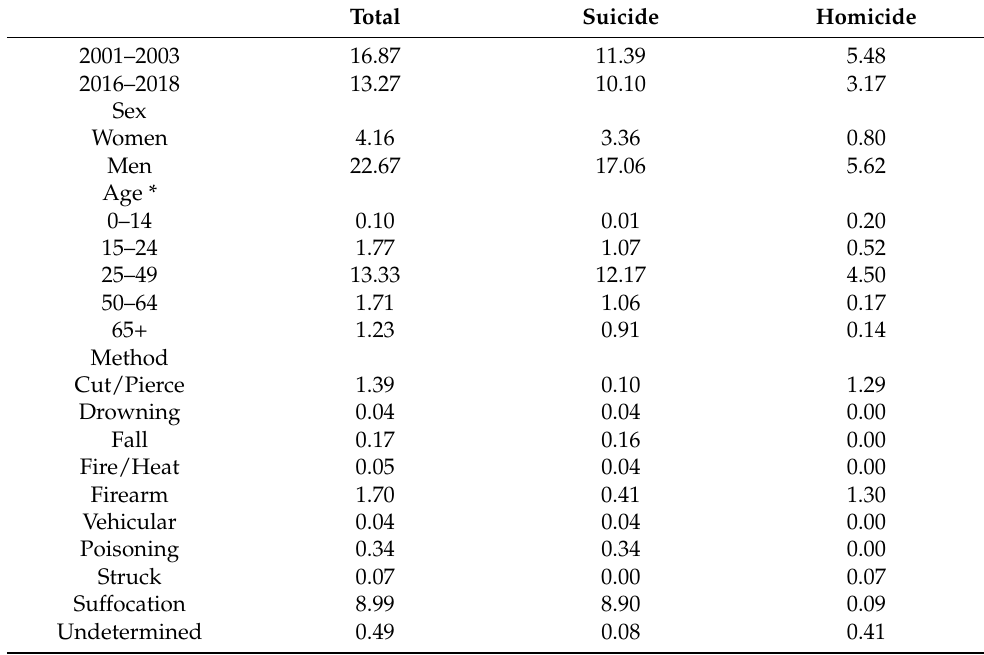
Table 3. Average age-adjusted mortality rates in Chile by sex, age, and method, 2016–2018.